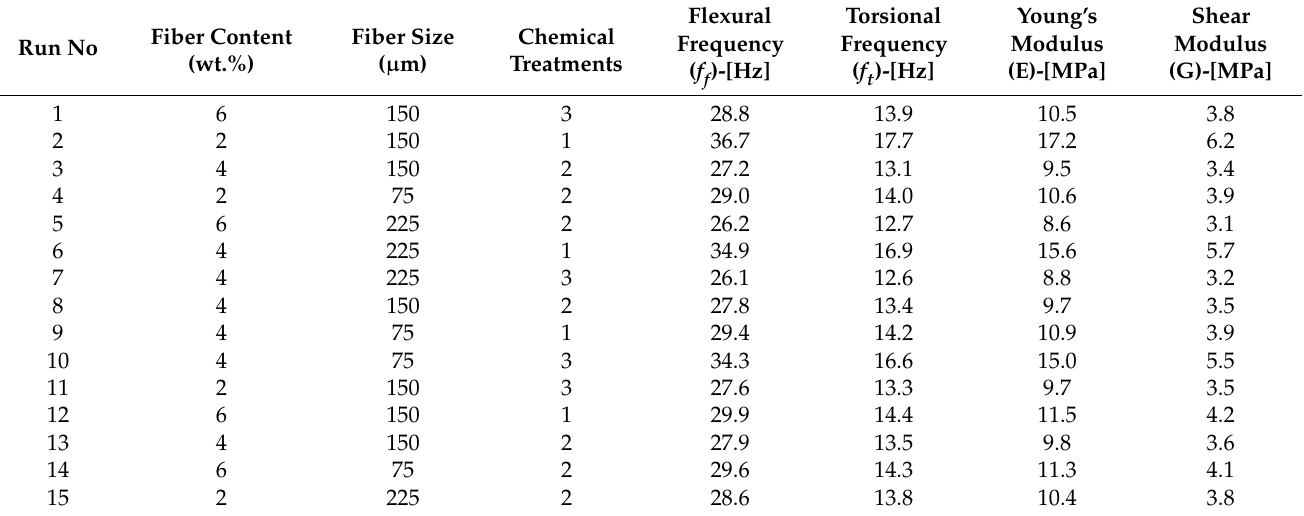
Table 3. Resonance frequency and elastic constants of samples.